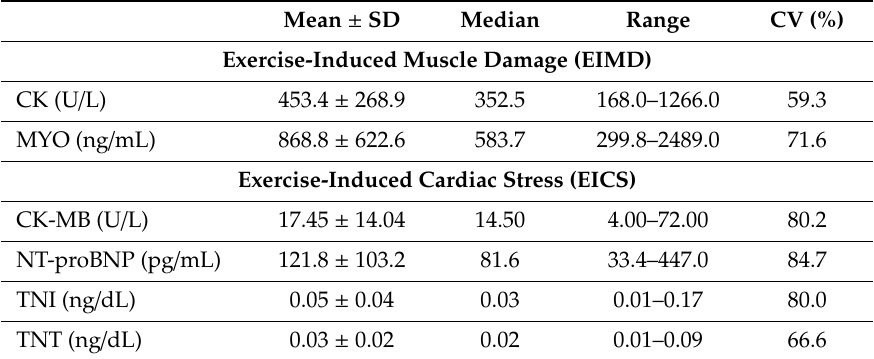
Table 5. Post-marathon exercise-induced muscle damage and cardiac stress parameters ( n = 69).